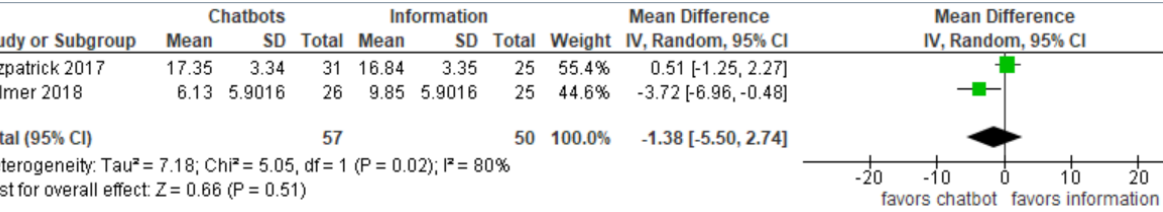
Figure 5. Forest plot of the 2 studies assessing the effect of using chatbots on the severity of